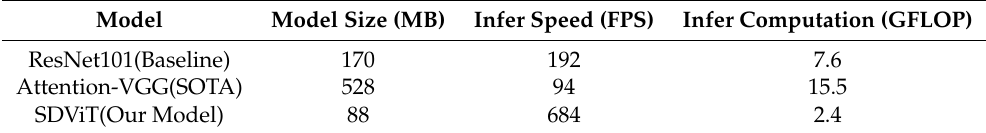
Table 10. Computational and time complexity of different